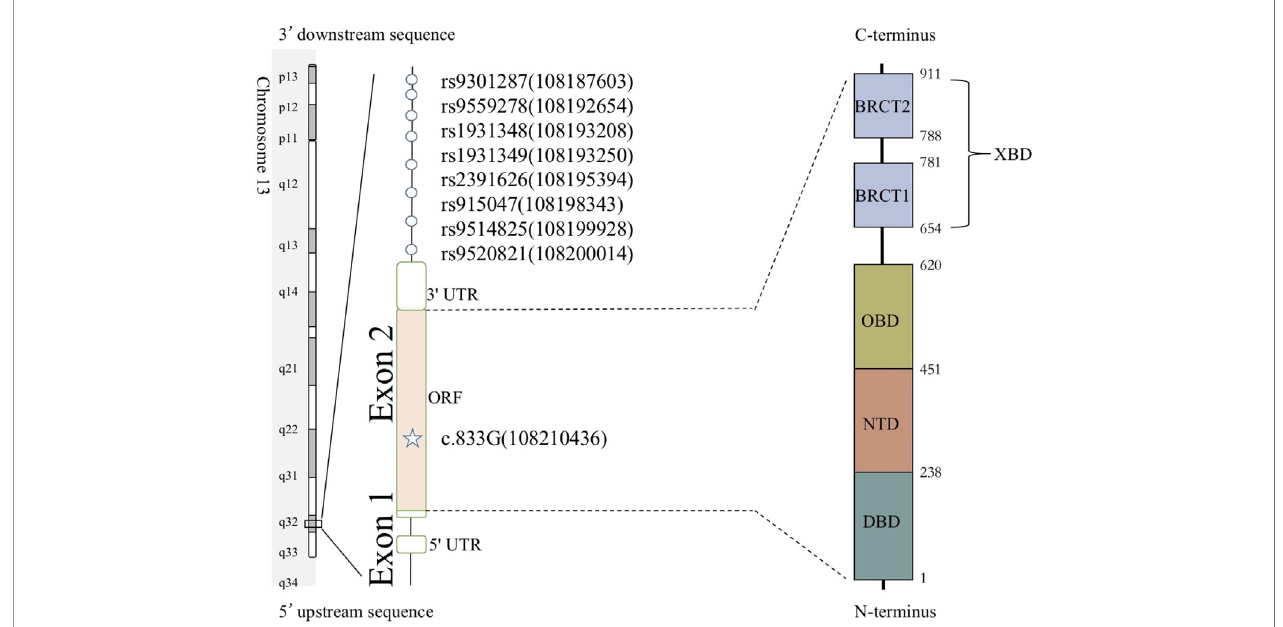
FIGURE 5 | Eight SNPs were used to reconstruct the haplotypes for the LIG4 mutation c.833G. The positions of genetic markers (shown in brackets) were de fi ned according to GRCh38.